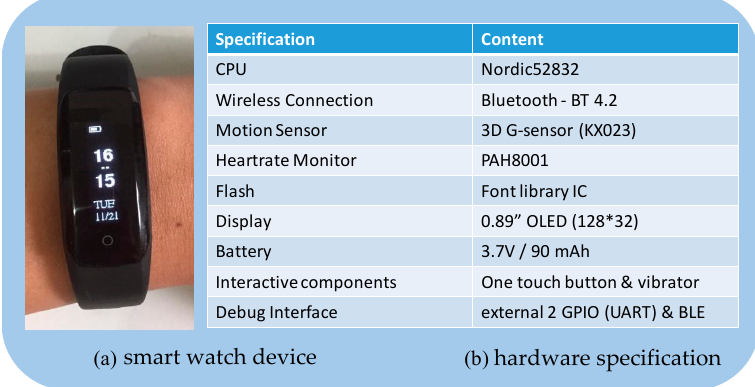
Figure 3. The specification of the Alfa Bracelet DS62.